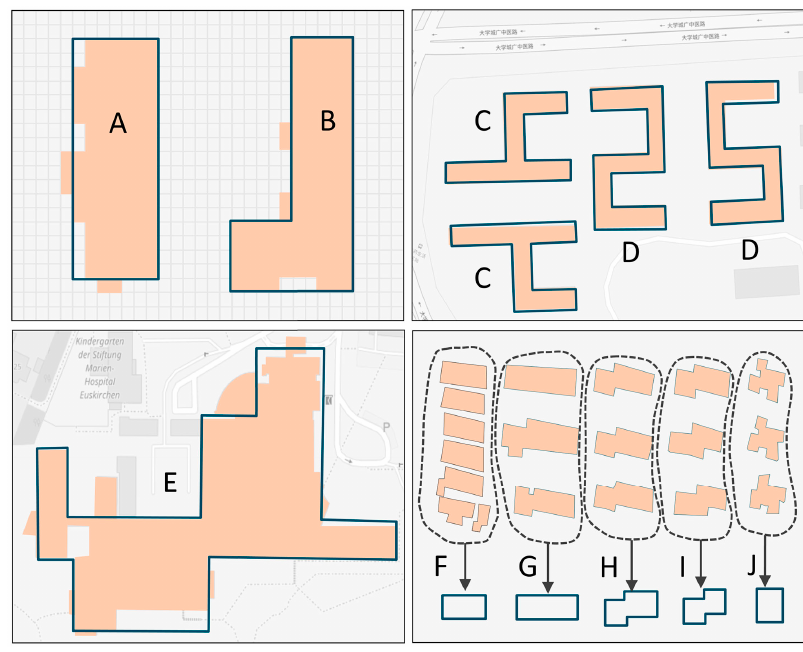
Figure 1. Illustration of four types of templates: templates ( A , B ) are simple shapes, ( C , D ) are symbolic shapes, ( E ) is a composite shape, and ( F – J ) are automatic extracted shapes.